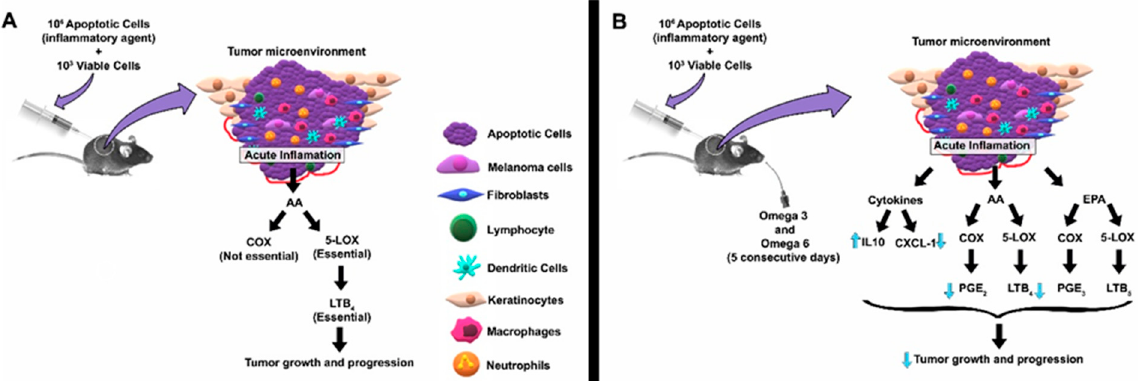
Figure 6. Representative illustration of the main findings of our group. In ( A) , the previous results published by Bachi et al [3] are presented. In ( B) , the results are shown. Arachidonic acid (AA); – cyclooxygenase (COX); CXC motif chemokine ligand 1 (CXCL1) -; interleukin 10